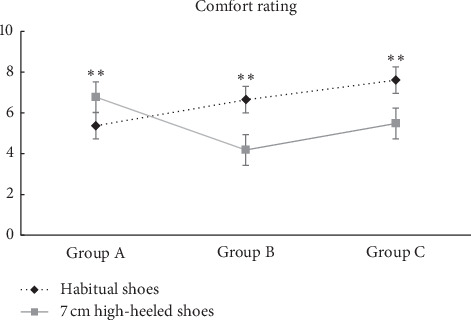
Comparison of comfort rating between 3 groups. ∗∗Significant difference between corresponding habitual shoes and 7 cm high-heeled shoes (p < 0.001).